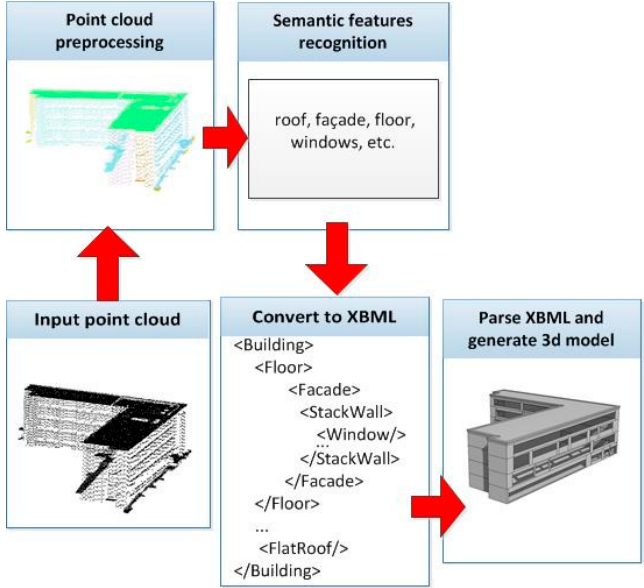
Figure 5. Workflow of the proposed semantic reconstruction.